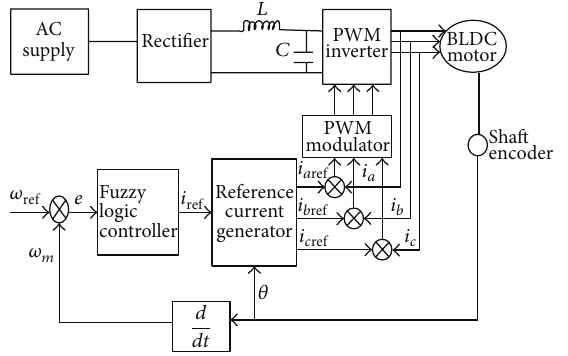
Figure 1: Block diagram of proposed setup.